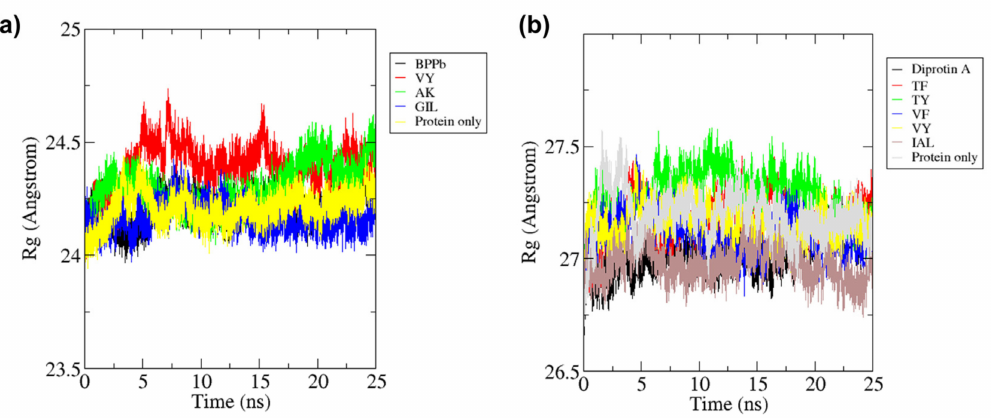
Figure 6. All-atom radius of gyration of ( a ) ACE and ( b ) DPP-IV as free proteins and forming complexes with the inhibitor peptides during 25 ns of the molecular dynamics simulation